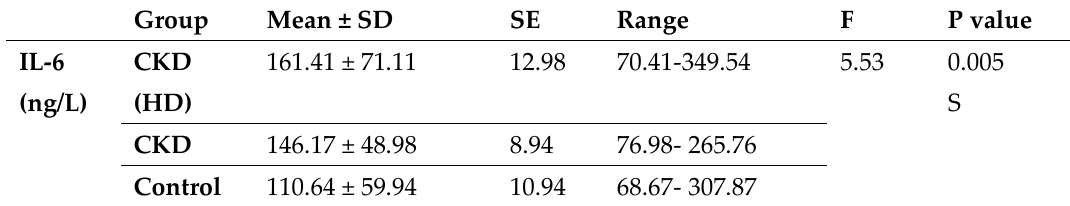
Table 5: Mean salivary interleukin- 6 of study groups with ANOVA test.